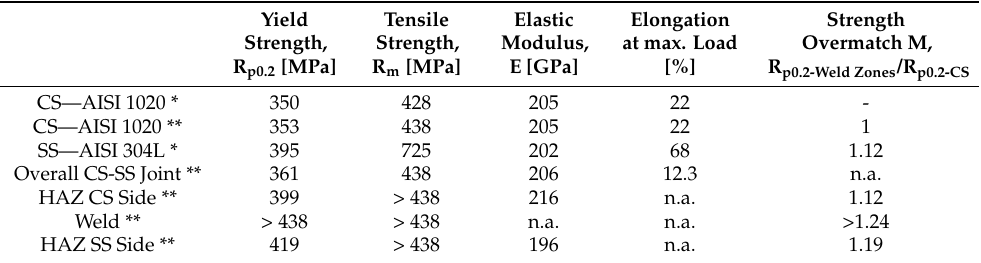
Table 3. Local and overall mechanical performance of the analyzed dissimilar laser-welded joint. Yield Strength, R p0.2